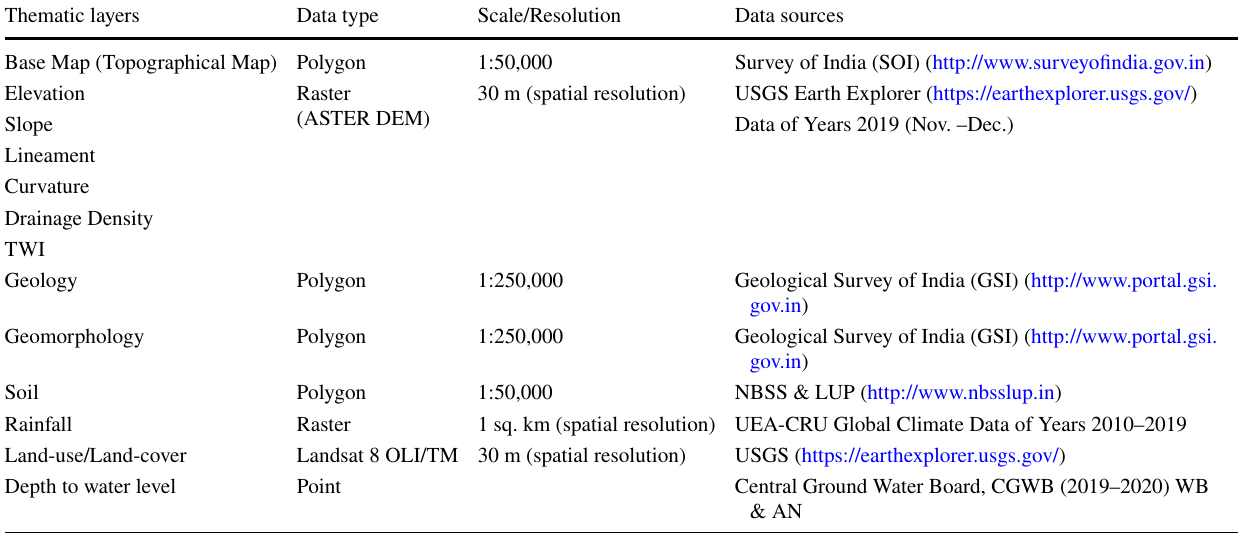
Table 1 Details of data sources used for thematic layers